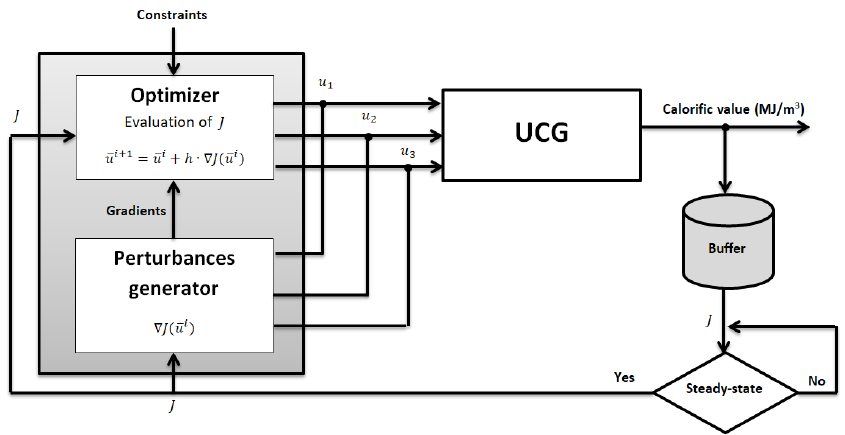
Figure 15. Principle of syngas calorific value